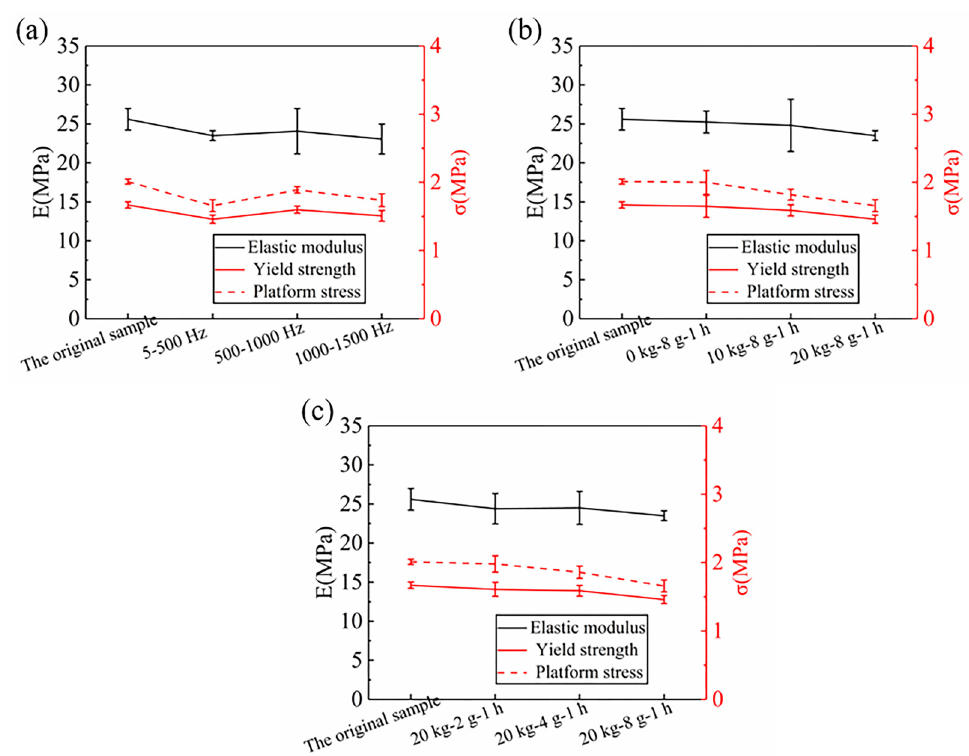
Figure 5. Compression properties of the RPUF under different vibration conditions, ( a ) Different frequency ranges, ( b ) Different mass blocks, ( c ) Different accelerations.